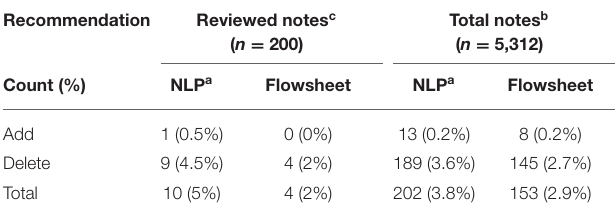
TABLE 4 | Number of allergy discrepancies for each recommendation